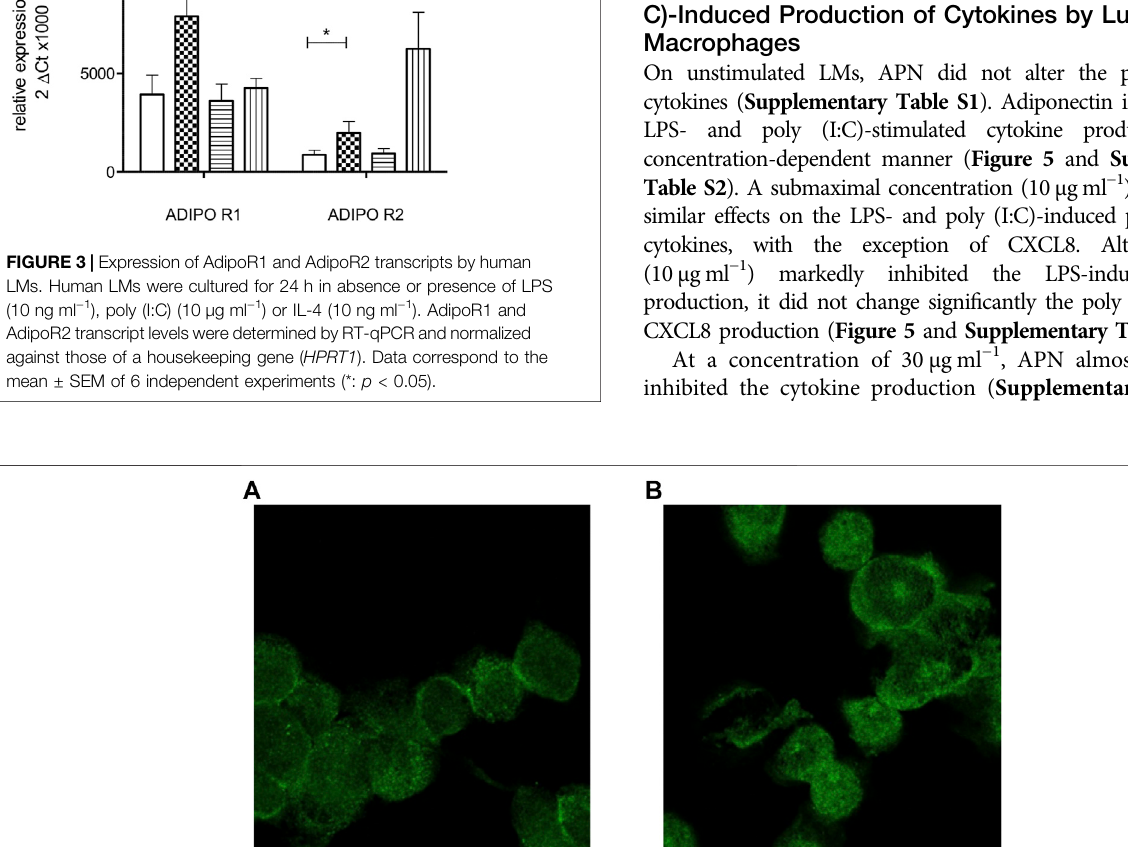
Frontiers in Pharmacology |